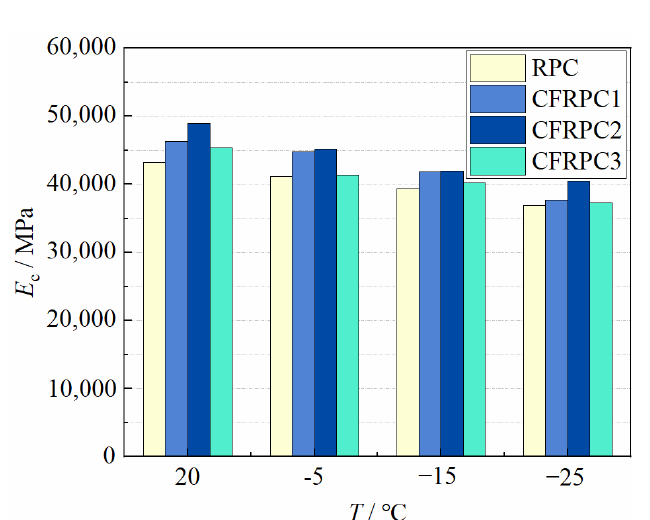
Figure 20. Relative E c vs. T.